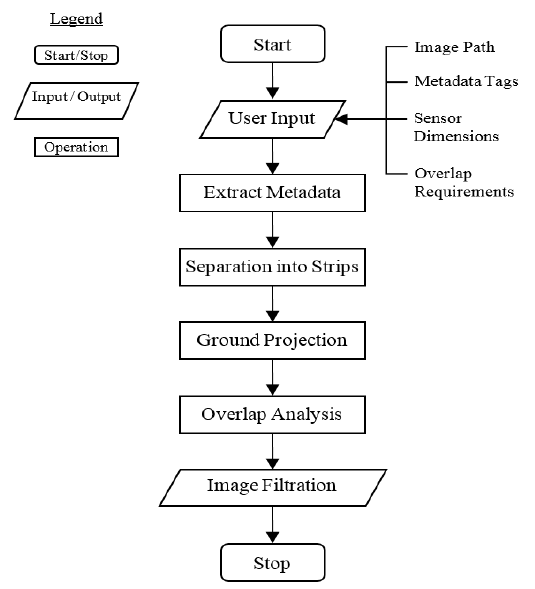
Figure 3. Methodology of the image filtering